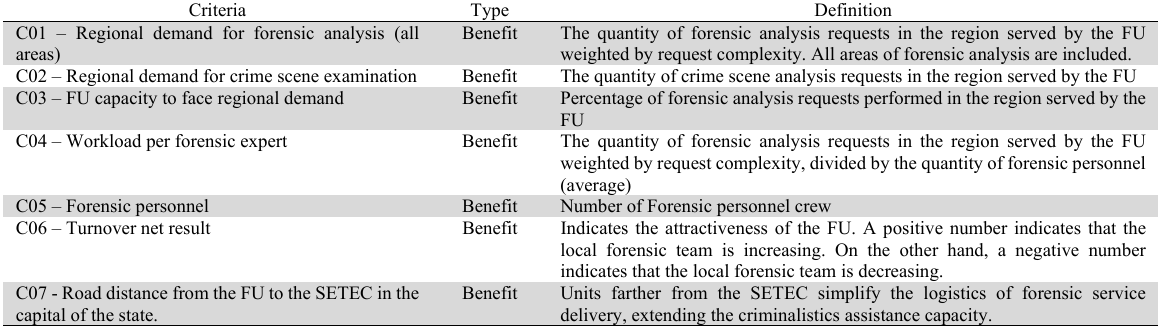
Criteria set developed by the experts